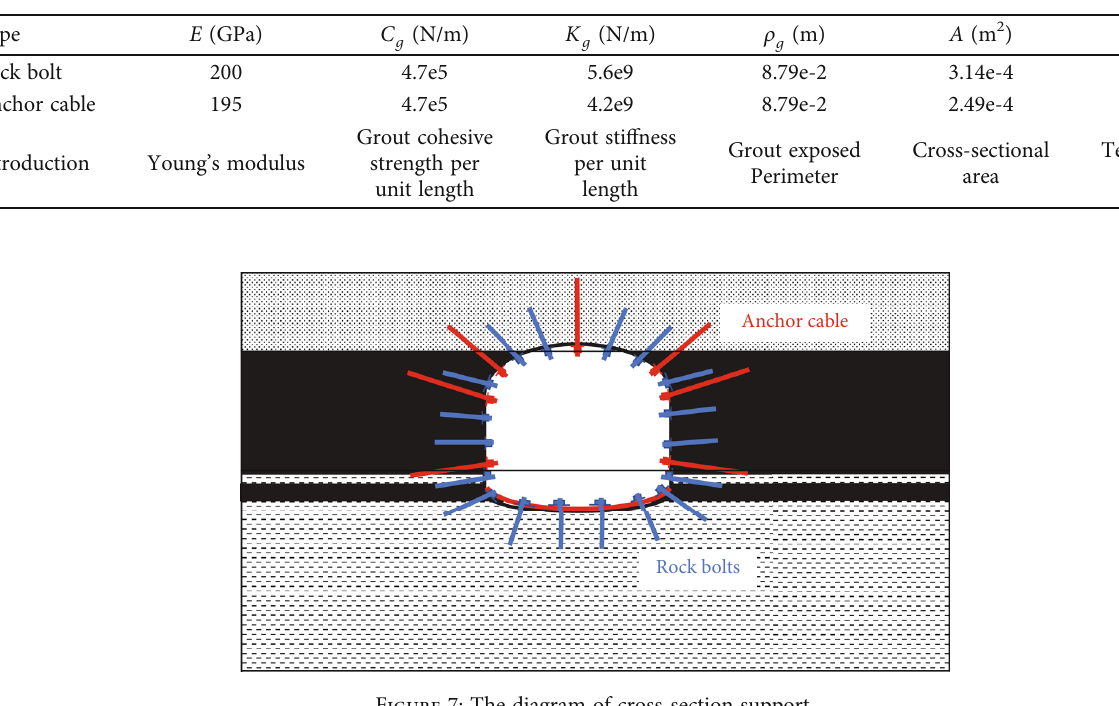
Table 2: Mechanical parameters of the blots